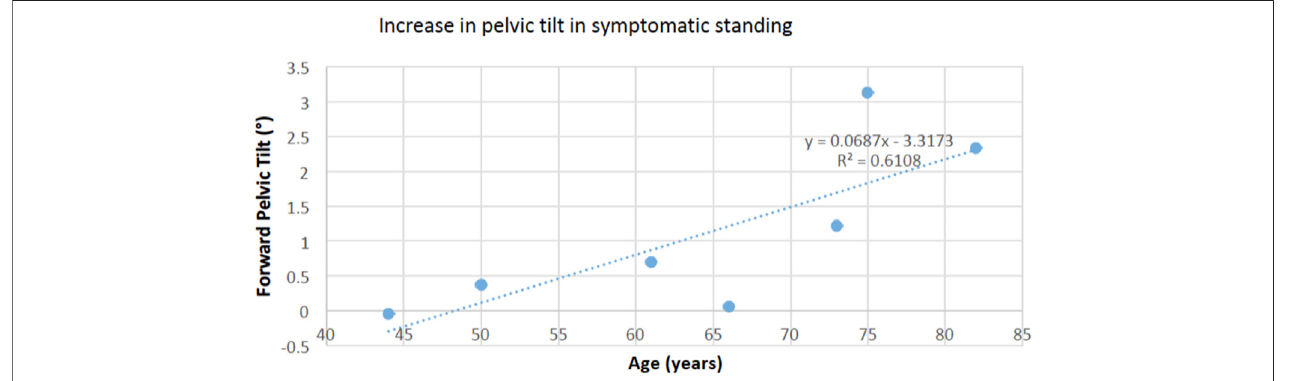
FIGURE 4 | The increase in forward pelvic tilt in symptomatic standing was positively associated with age ( p (cid:1) 0.038), suggesting a larger effect in older adults.